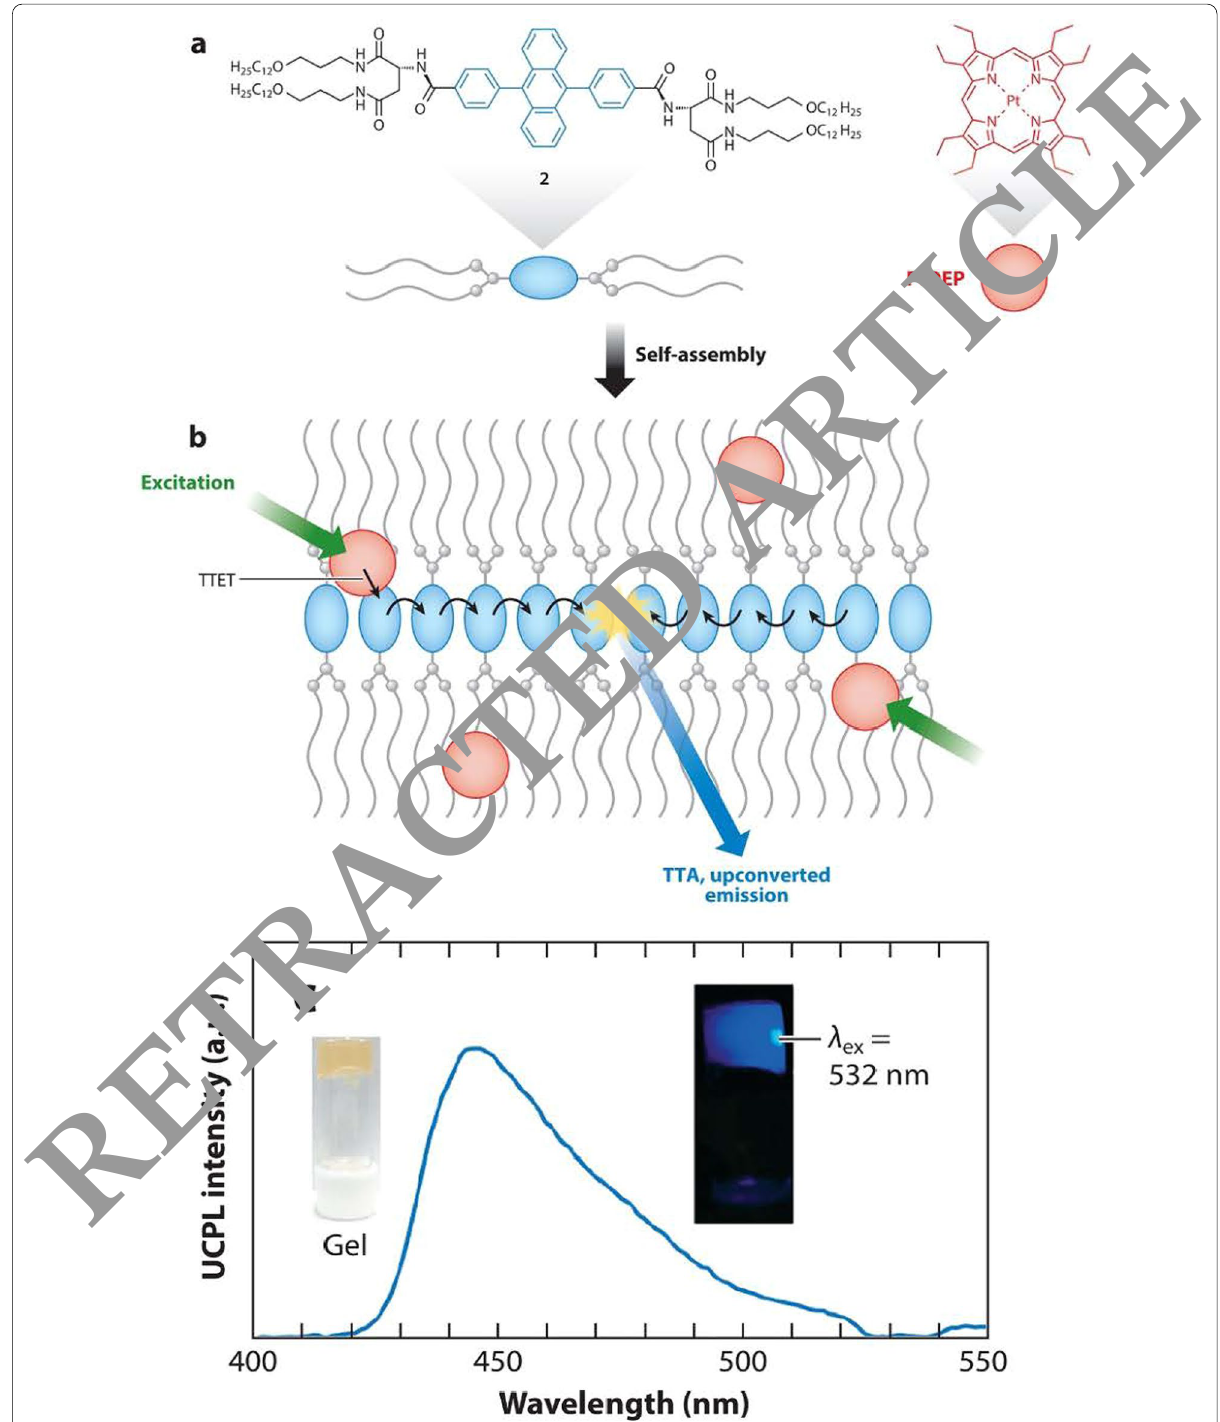
Fig. 4 Molecular structures: a conductive gels and electron donor centers; b a schematic of the specific spatial arrangement of the two-phase structure of the conductive gel–electron donor centers after doping; the photon upconversion phenomenon is shown schematically; c the photoluminescence spectrum of a conductive gel doped with electron donor centers; and the emission of light output is done in the wavelength range of 400 to 475 nm. In this study, 9,10-diphenylanthracene acted as conductive gels (electron receptor centers) and PtOEP acted as electron donor centers